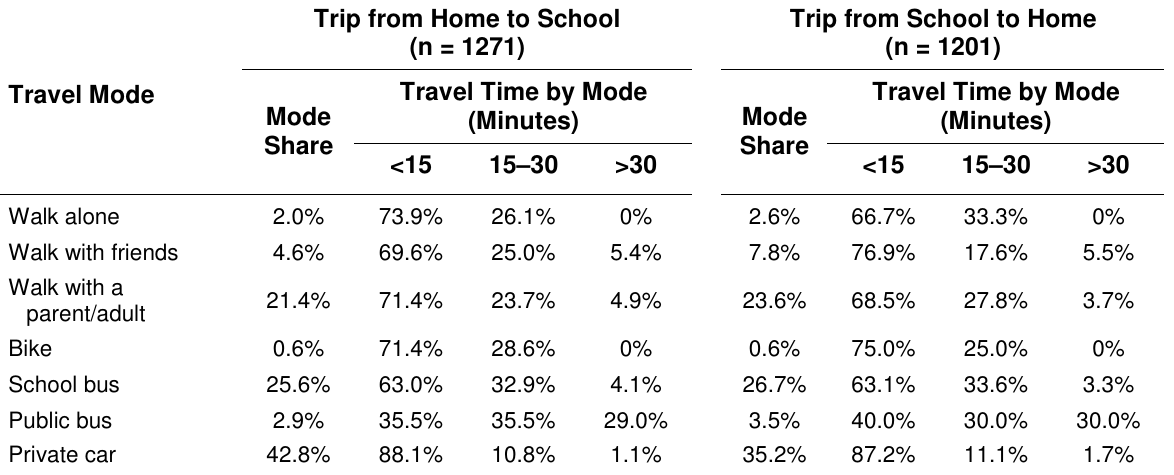
Travel Mode and Travel Time of the Pooled Sample from Eight